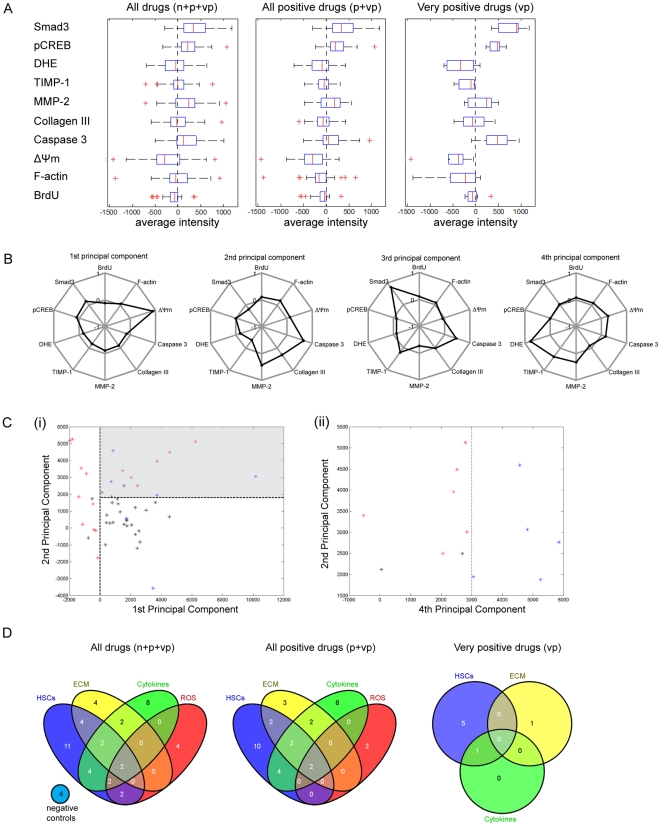
Distinctive characteristics of the negative (n), positive (p), and very positive (vp) groups of drugs.(A) The average intensities of the 10 makers for all drugs (n+p+vp), all positive (p+vp) drugs and the vp group of drugs are shown in the boxplots, where inter-quartile ranges are represented by boxes. Whiskers represent 1.5 times the inter-quartile range and any data (outliers) beyond the whiskers are shown using red +. (B) Principal component analysis (PCA) is done using data from the vp group. The top 4 principal components explain 95% of the cumulative variance in the system. (Ci) All 49 drugs are mapped to the first and second principal component coordinates. Drugs in the gray box in (Ci) are mapped to the second and fourth principal component coordinates in (Cii). The vp group (blue) is found to have relatively large values in the first, second and fourth principal components; while the p group (black) has positive values in the first principal component, but relatively low values in the second principal component. (D) All drugs (n+p+vp), all positive (p+vp) drugs and the vp group of drugs are classified into 4 categories according to their mechanisms of action.